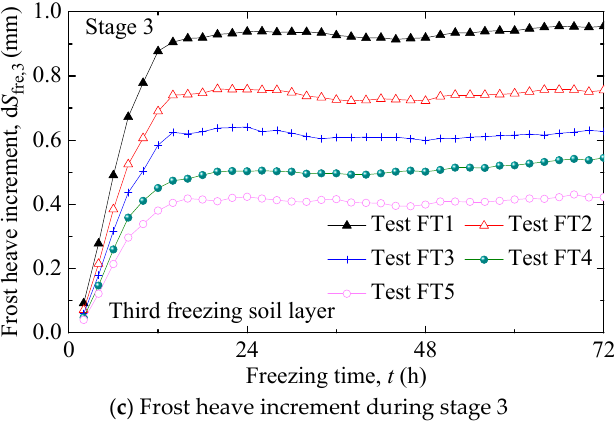
Figure 9. Frost heave increment generated in the freezing soil layers during ( a ) stage 1, ( b ) stage 2, and ( c ) stage 3.